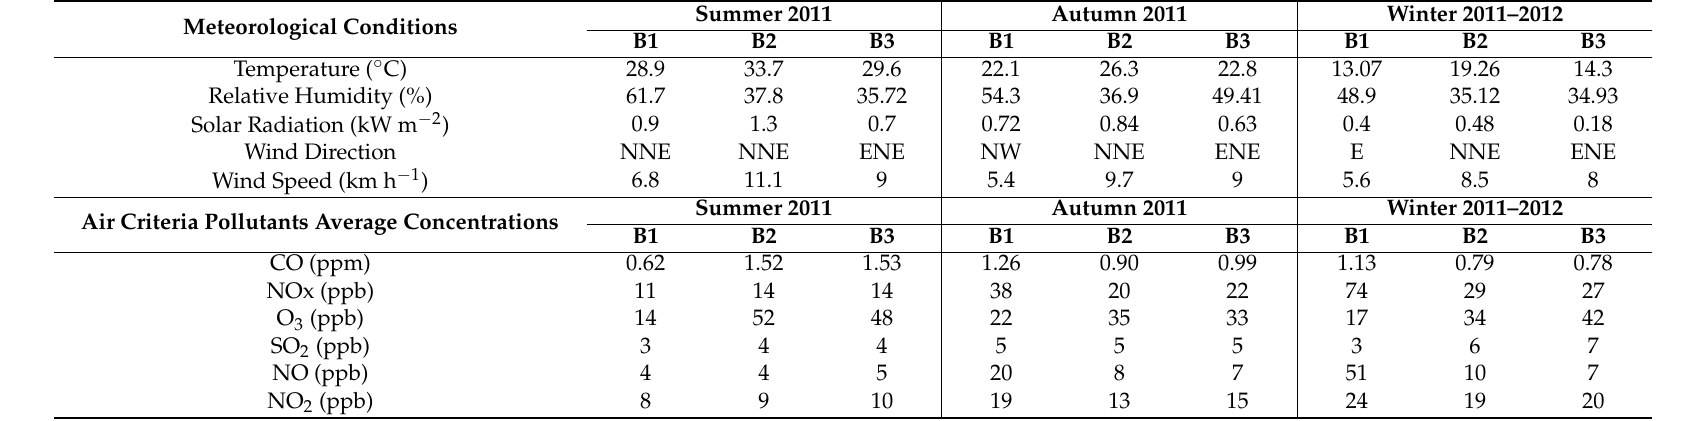
Table 3. Meteorological conditions and Air Criteria Pollutants